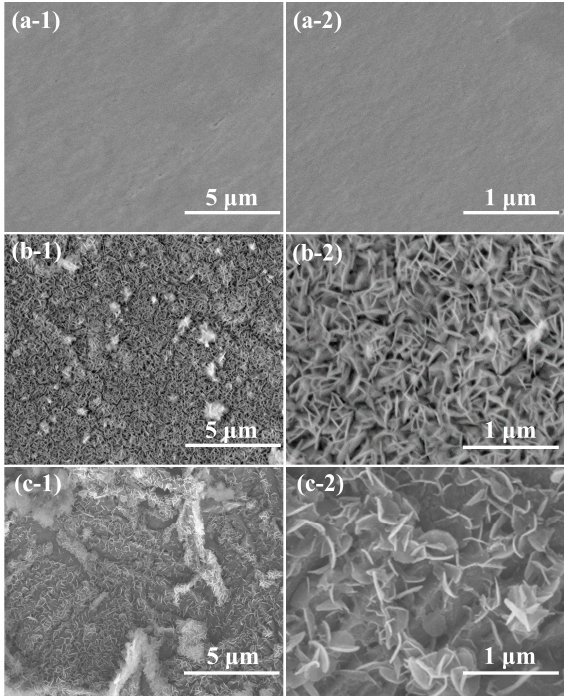
Figure 1. SEM images of polished Q235 carbon steel surface ( a ), structured Q235 carbon steel surface ( b ) and structured surface after modification of PFTEOS ( c ). (-2 is the high magnification image of -1, respectively).